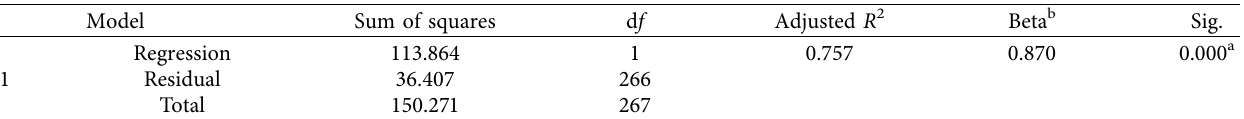
Table 8: Reverse